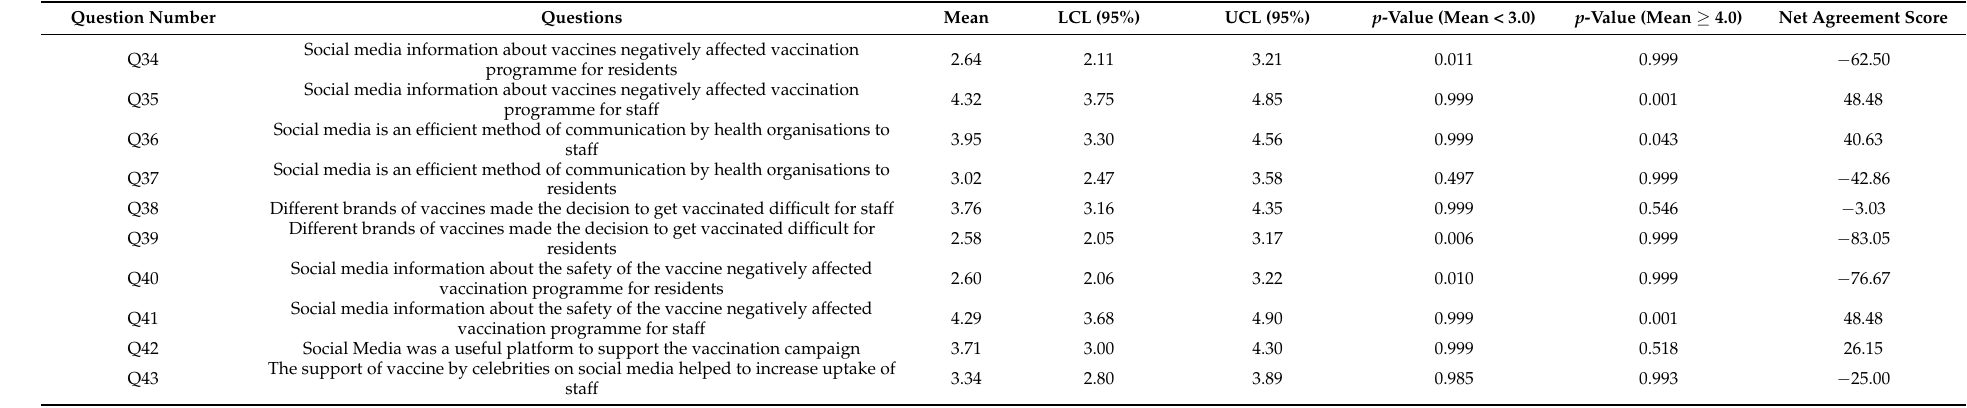
Table 5. Analyses of the impact of social media and source of information on uptake level of COVID-19 vaccination programme in care homes by staff and residents.